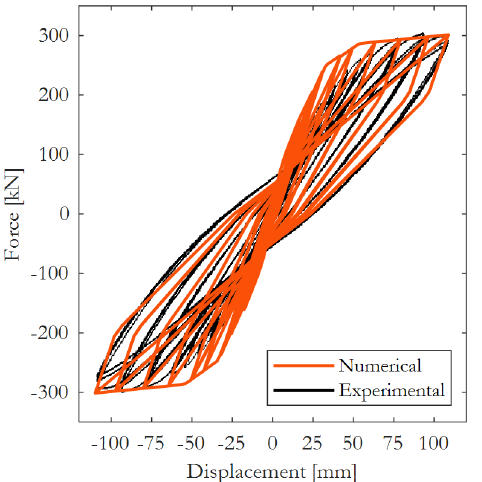
Figure 9. Comparison between numerical and experimental results of the test by Morandi et al. [5].